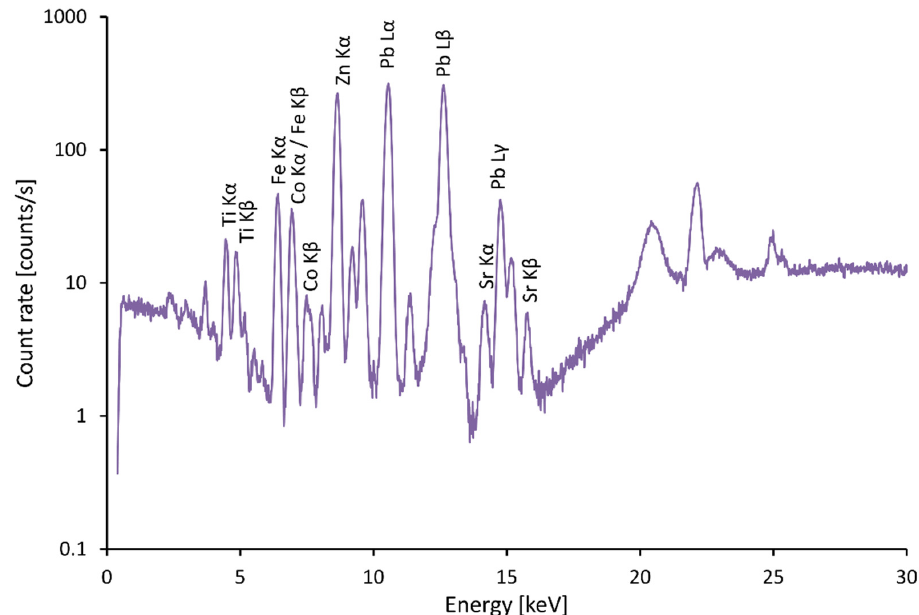
Figure 6. Spectrum of azurite, Coat of arms in left bust of Anna Palatinate (Anna Pfalz).